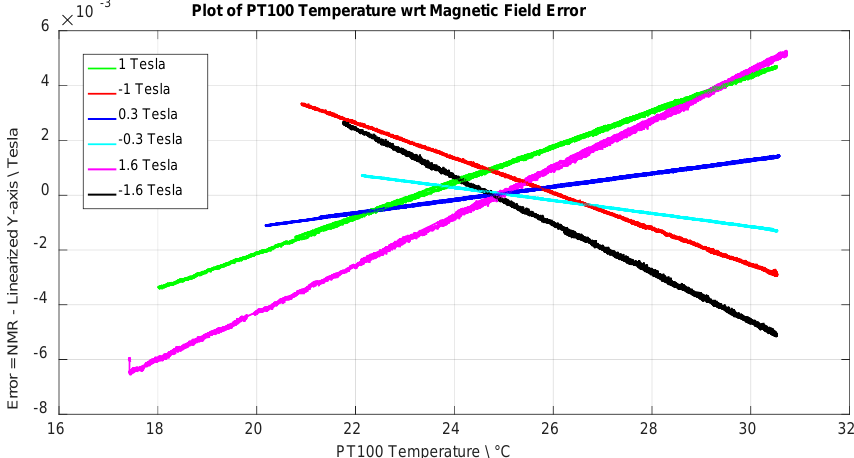
Figure 15. Superposition of all the errors obtained for each of the 6 magnetic field plateaus tested.